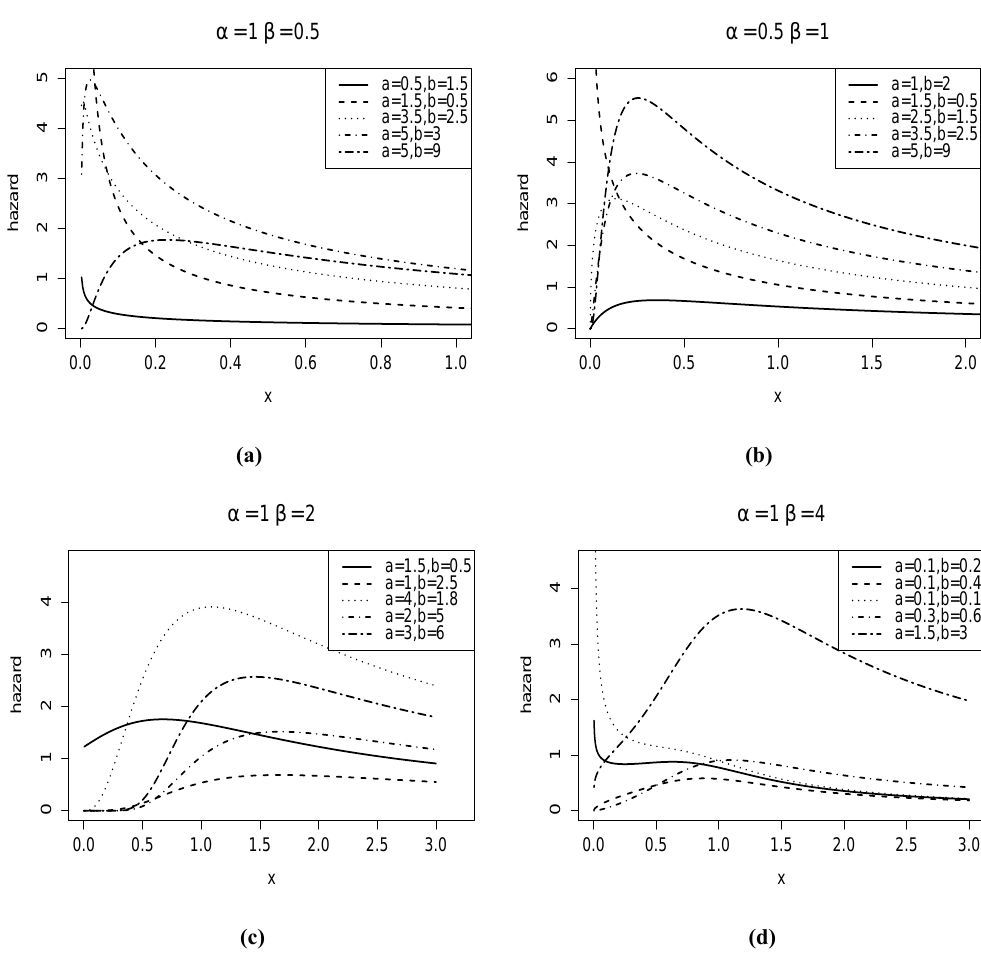
Figure 2 - Plots of the ELL hrf for some parameter